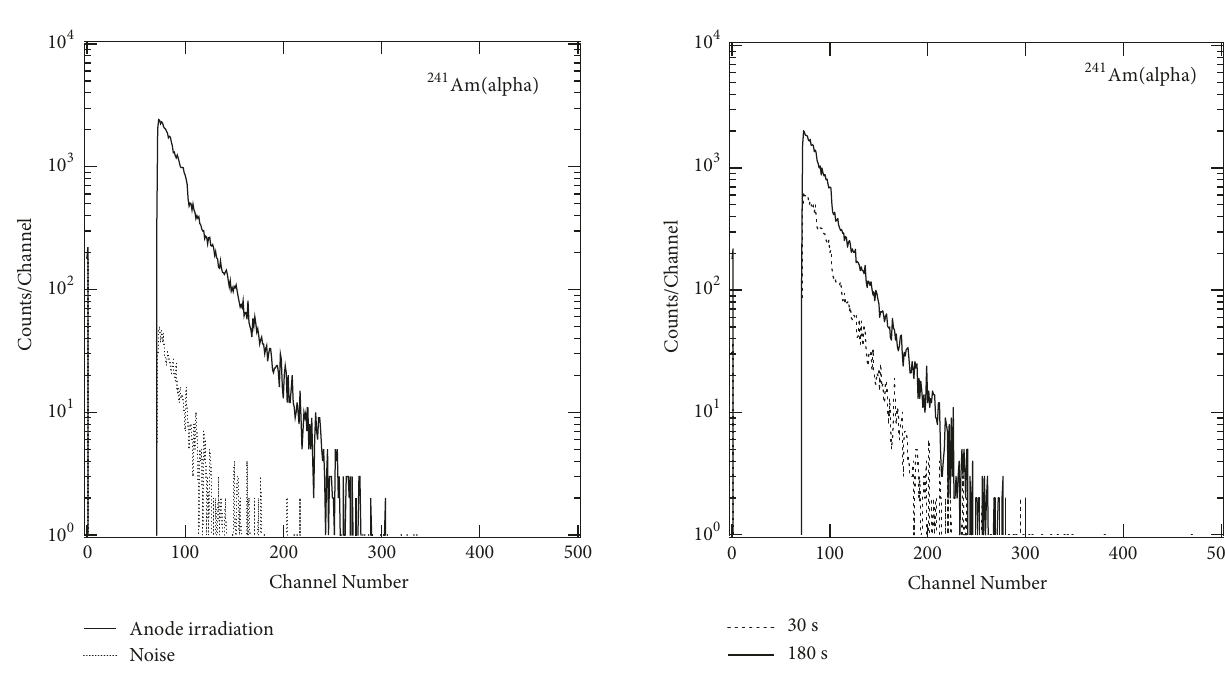
Figure 9: Alpha-particle energy spectrum obtained from the SbI 3 detector under anode irradiation (holes mainly transport in the crystal).